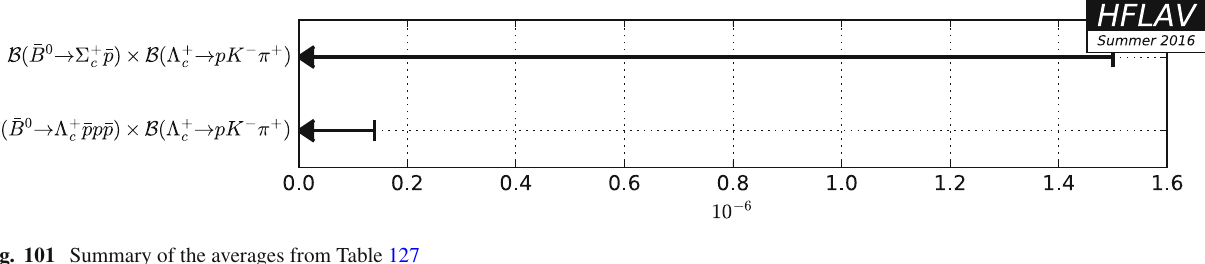
Fig. 101 Summary of the averages from Table 127